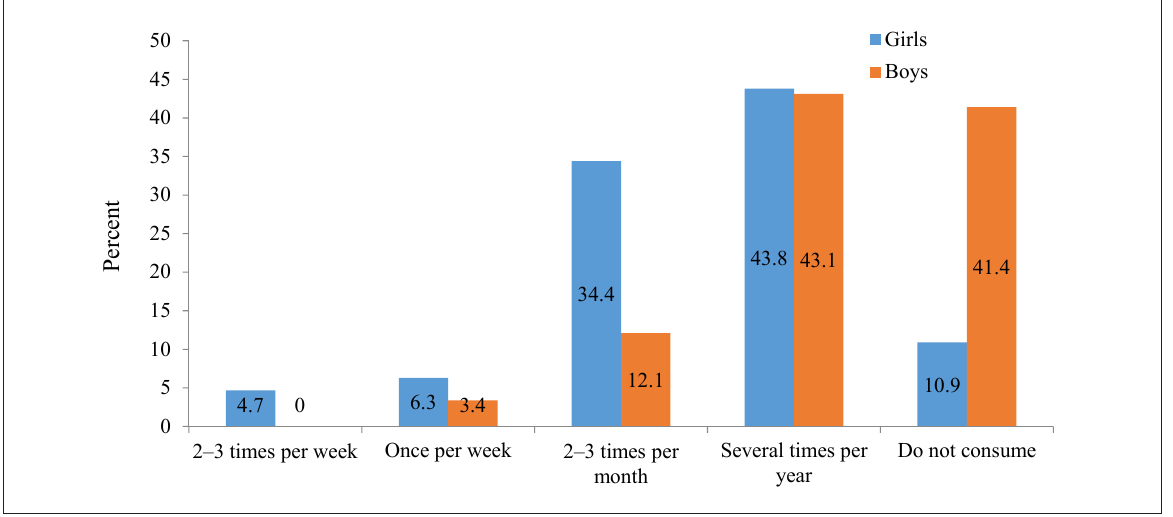
Figure 2. Frequency of wine consumption according to gender